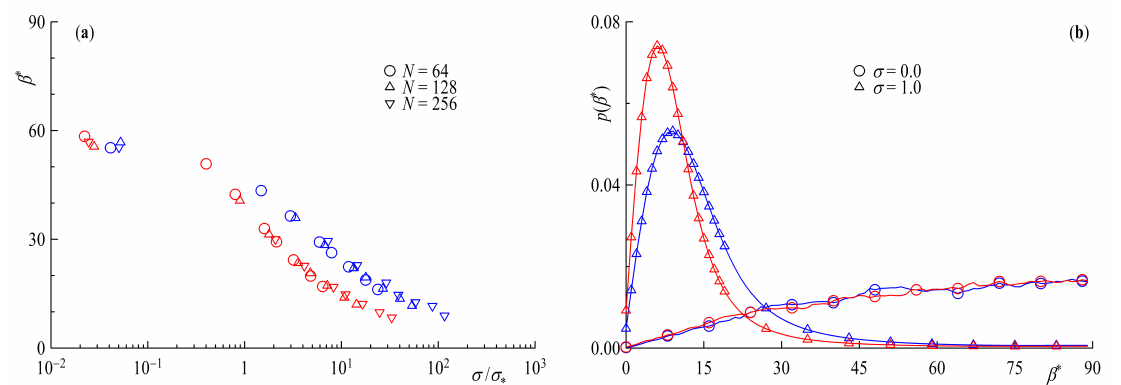
Figure 9. ( a ) Angle between the normal to the surface and the largest eigenvector of the gyration tensor β ∗ as a function of the surface overlap concentration σ / σ ∗ and ( b ) frequency distribution F ( β ∗ ) for N R = 128 and N L = 64. Red symbols are rings and blue for